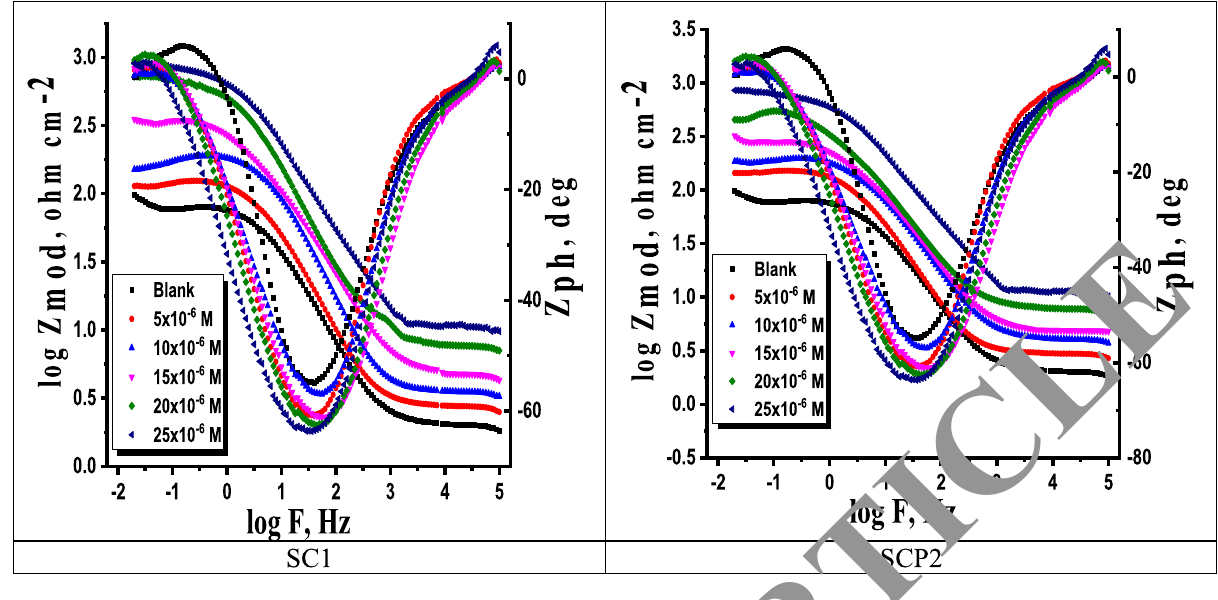
Figure 10. Bode graphs for C-steel dissolving in 0.5 H 2 SO 4 in the presence and absence of different dosages of metal–organic SC1 & SCP2 at 298 K.